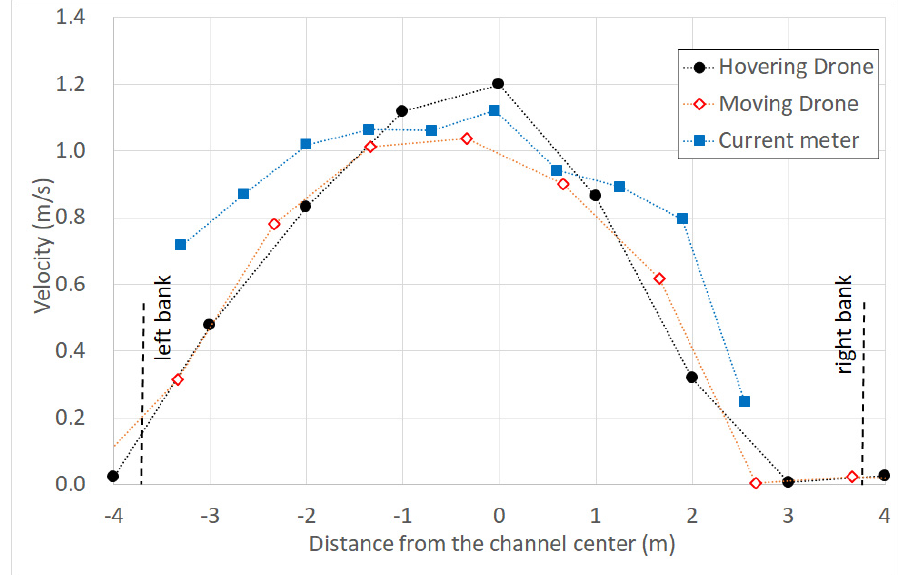
Figure 7. Velocity distribution (Andong Experimental Station).